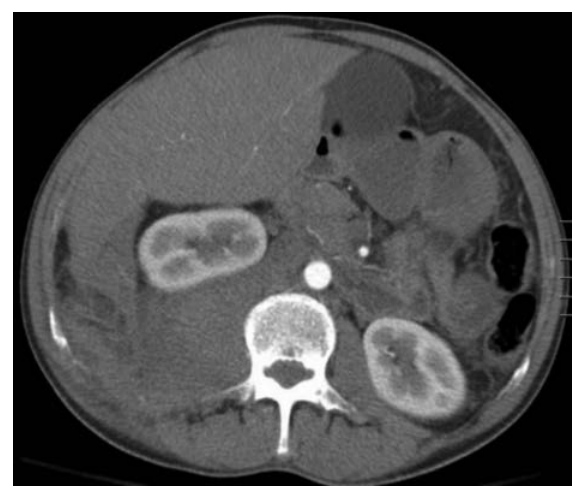
Figure 3. Large right retroperitoneal hematoma displacing right kidney